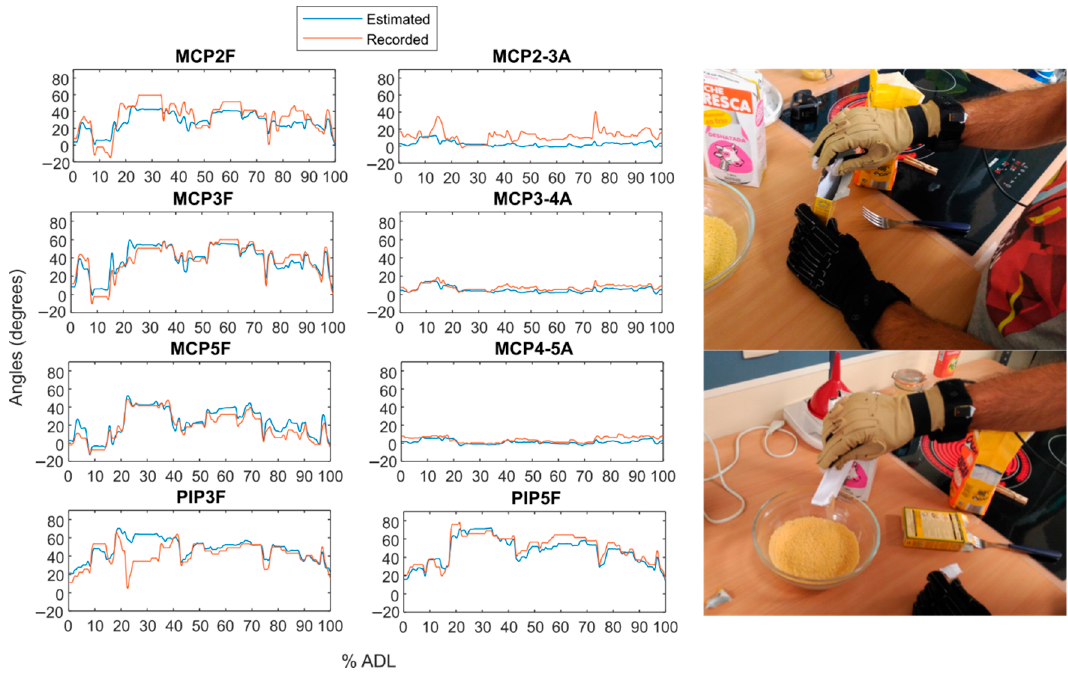
Figure 10. Estimated versus recorded angles for action 21 (“Pouring baking powder into the bowl”). 1 to 5 refers to thumb to little fingers. F stands for flexion/extension and A for abduction/adduction movements.